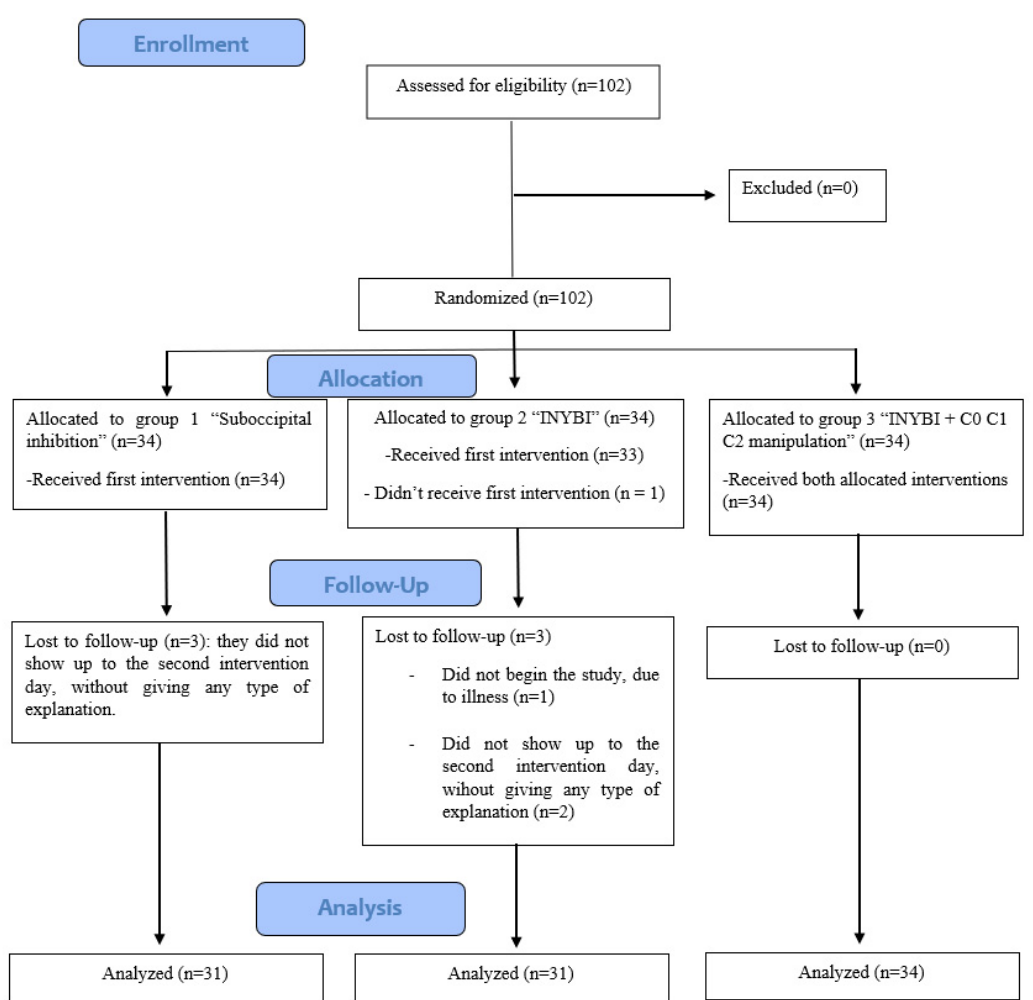
Figure 1. Flowchart of study participants according to CONSORT.